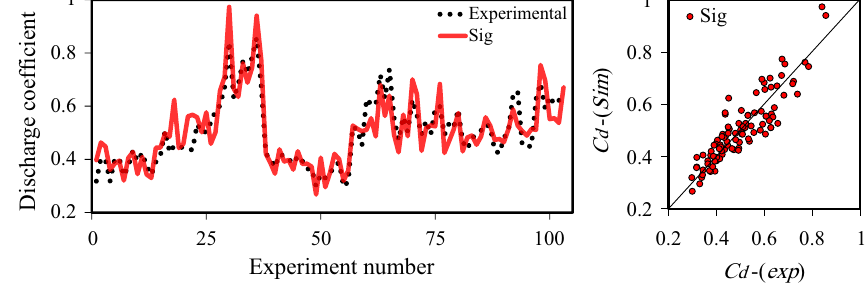
Fig. 7 Discharge coefficients simulated by activation function sig and comparison with experi- mental